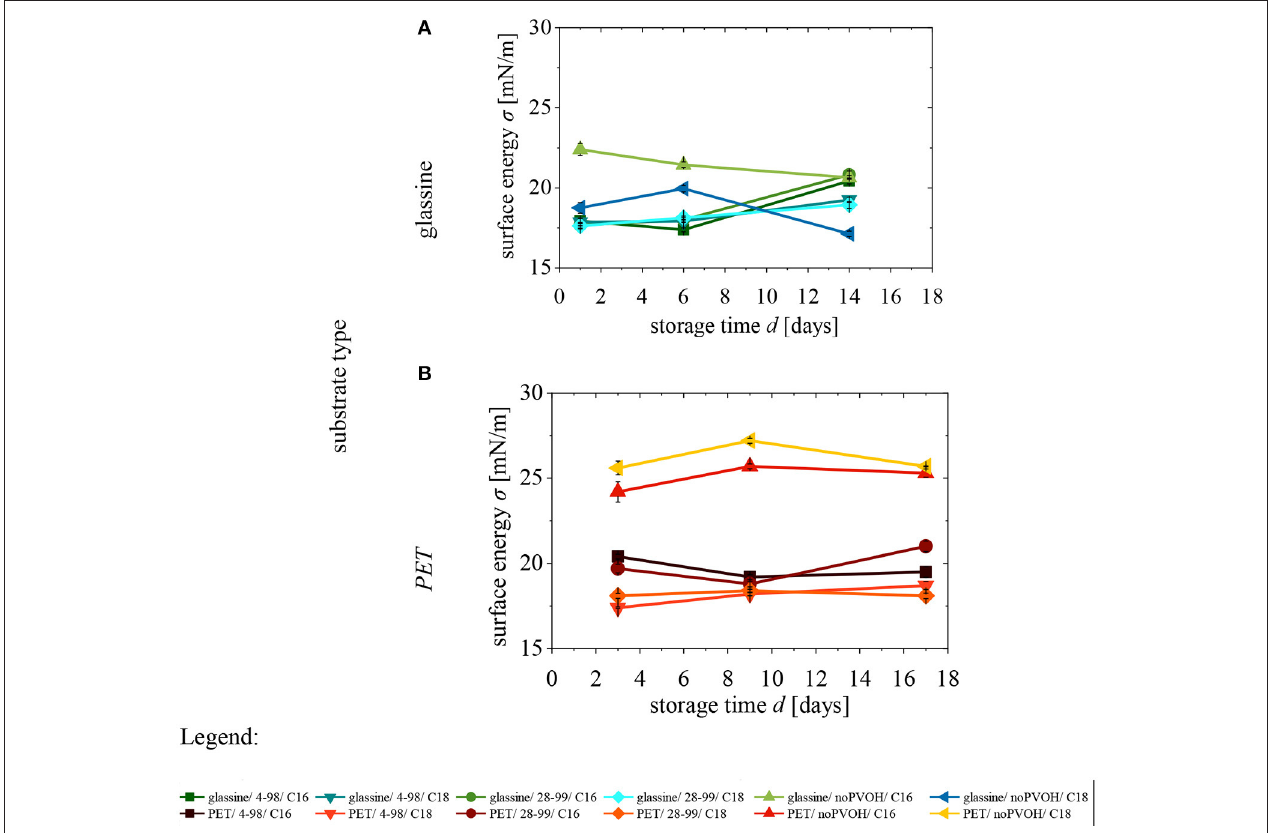
FIGURE 4 | Surface energy of (A) glassine and (B) PET over storage time. Error bars show standard deviations. n = 5 ( Supplementary Tables 3 , 4